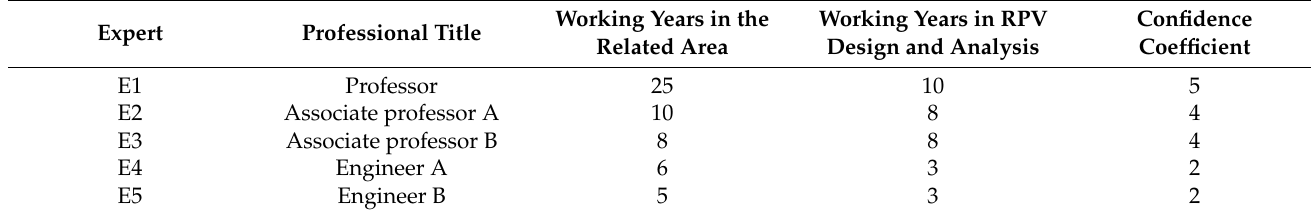
Table 2. The confidence coefficients for the knowledge provided by